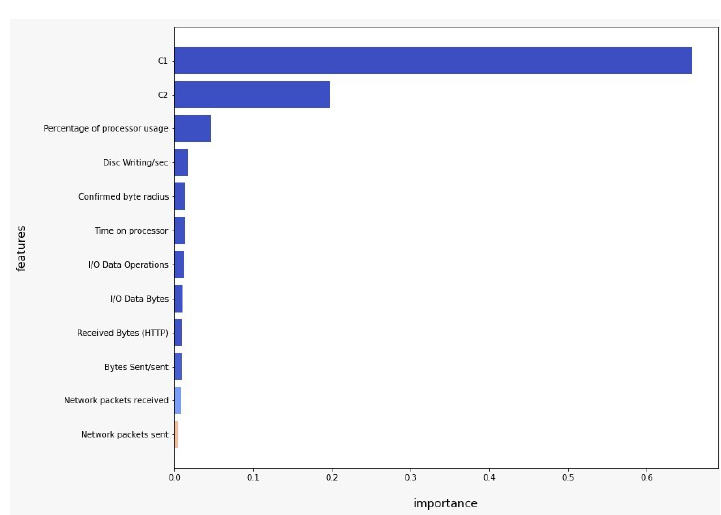
Figure 5. Feature importance logistic regression model.